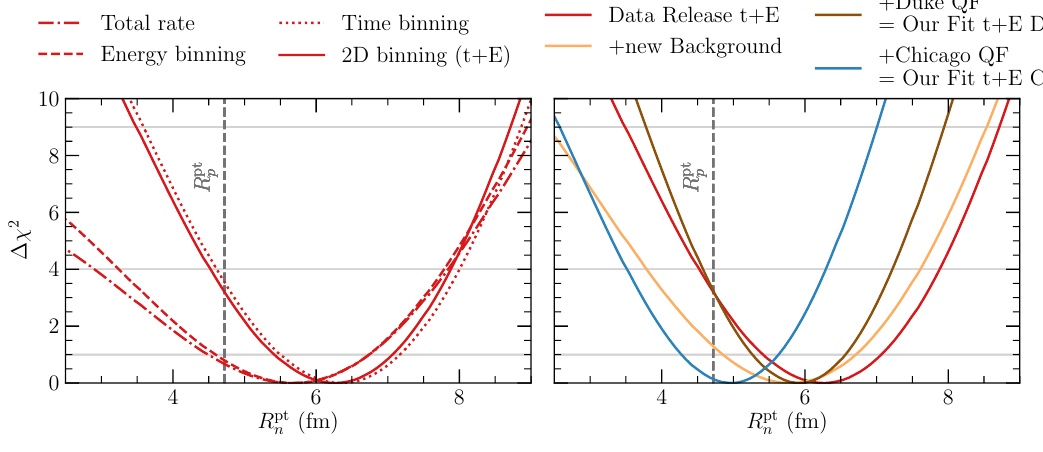
Figure 1 . (cid:1) (cid:31) 2 as a function of the rms radius of the point-neutron distribution R pt (assumed to be equal), for a variety of (cid:12)ts to COHERENT data as indicated by the labels. In all cases shown in the left panel, the QF and background assumptions are those employed in the data release [3]. On the right panel we show the dependence of the results on the assumptions for SS background modeling and QF implementation. For convenience, the vertical line indicates the value of the rms radius for the proton distribution. This is taken as the average between their values for Cs ( R pt ; Cs = 4 : 75 fm) and I ( R pt ; I p